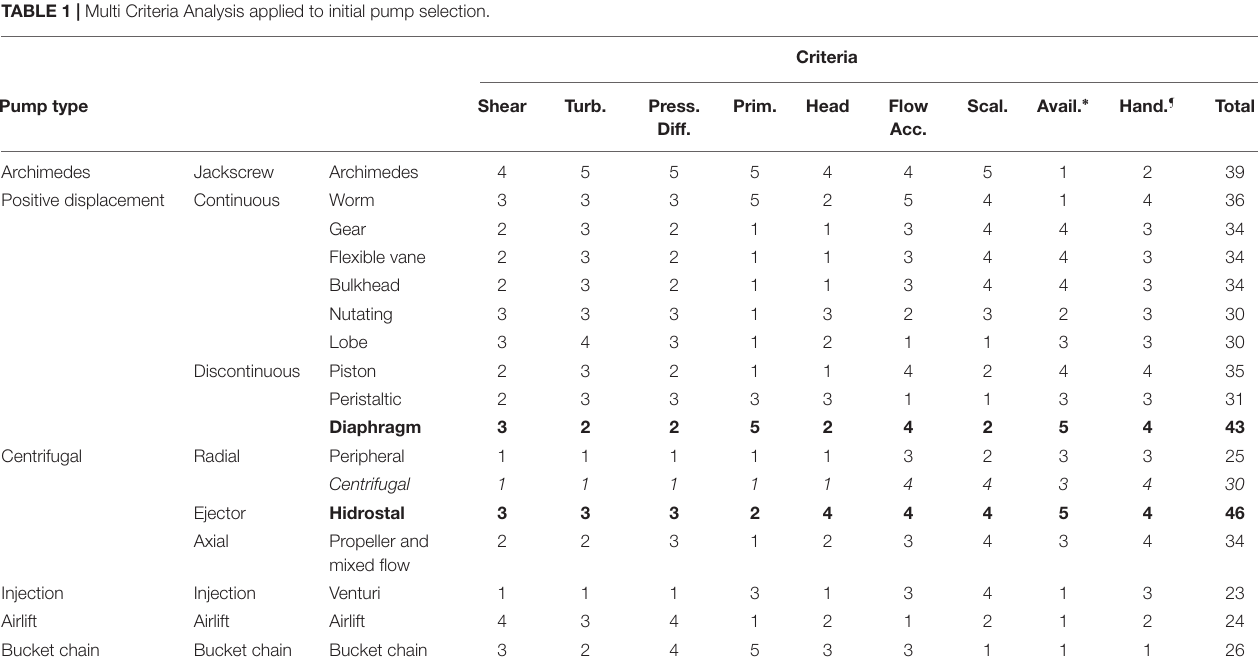
TABLE 1 | Multi Criteria Analysis applied to initial pump selection.